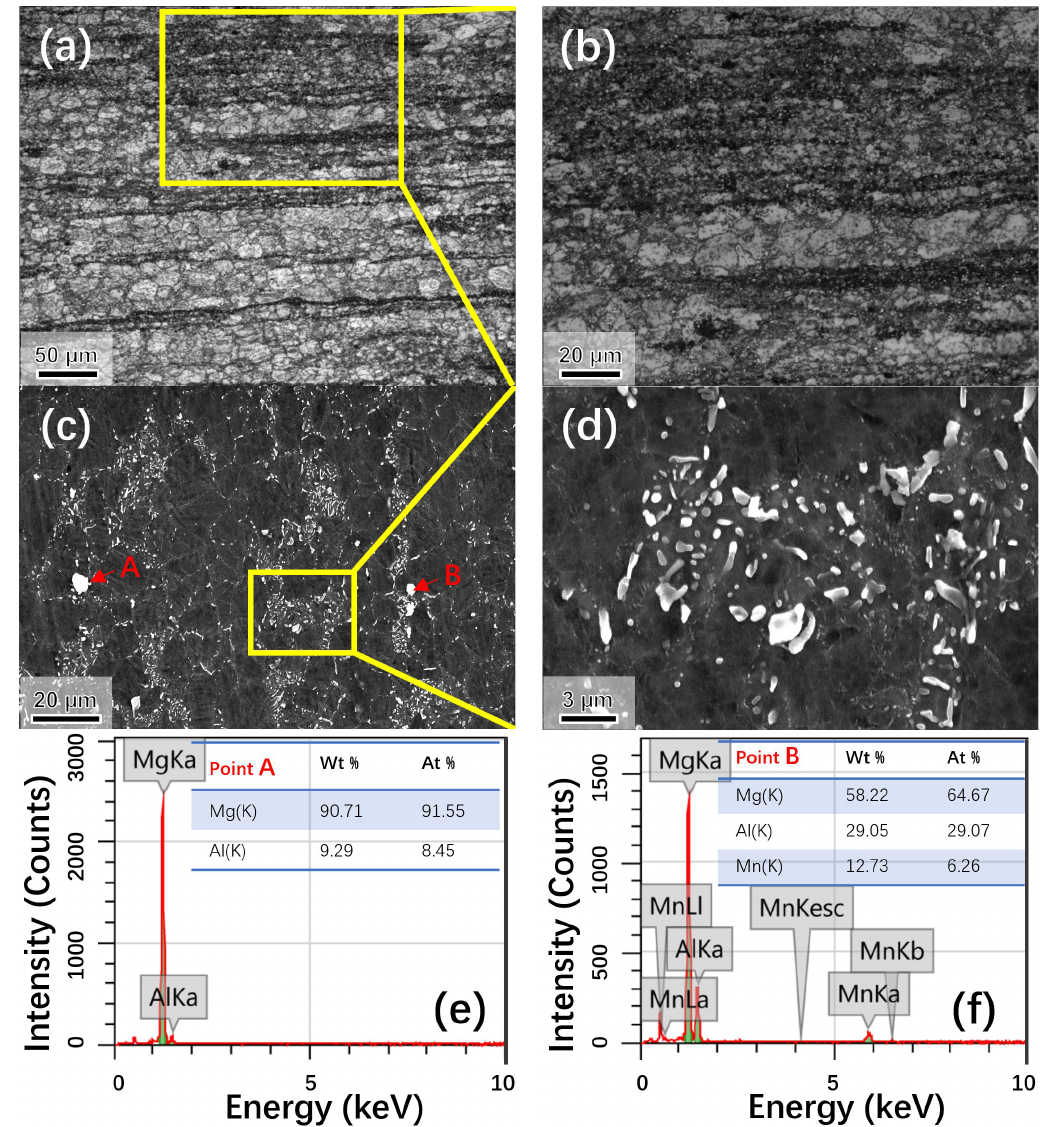
Figure 5. ( a , b ) Ooptical microscope (OM) and ( c , d ) SEM micrographs of CRed AZ80 alloy; ( e , f ) EDS data of ( e ) particle A and ( f ) particle B in ( c ).